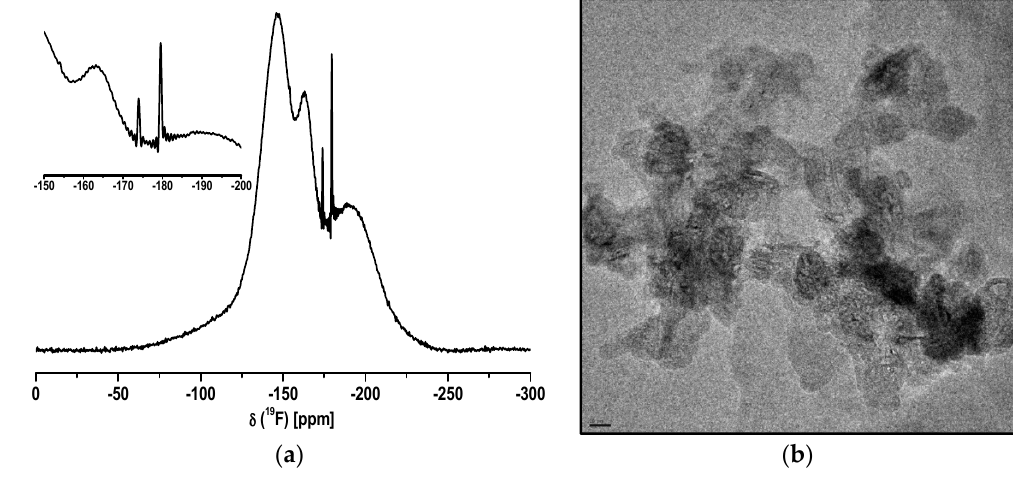
Figure 1. 19 F liquid NMR spectrum ( a ) and TEM image ( b ) CaAlF 5 sol in EtOH (scale bar = 20 nm).